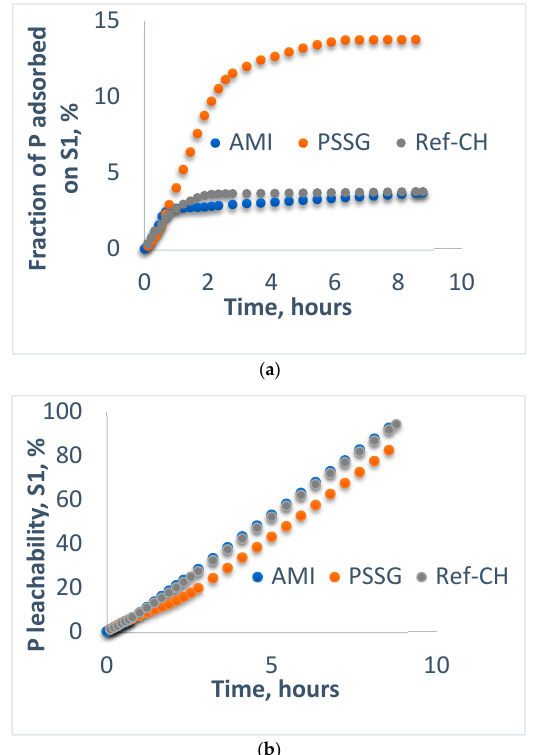
Figure 2. Fractions of phosphorus adsorbed ( a ) and leached ( b ) for the fertilizers on sand and soil S1-L.